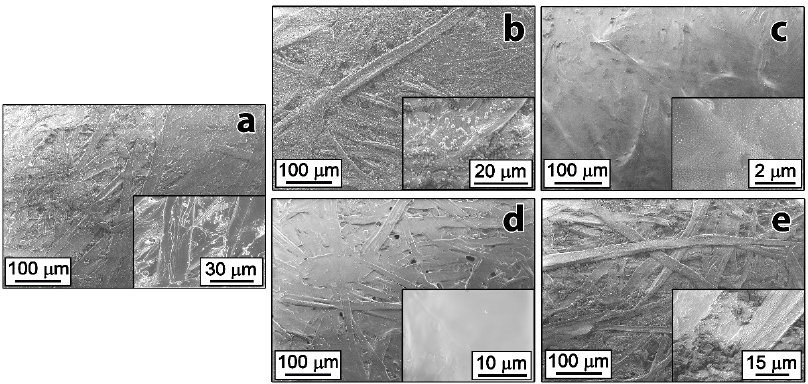
Figure 2. SEM images of paper surface ( a ) before and ( b–e ) after treatment with pre-coating blends: